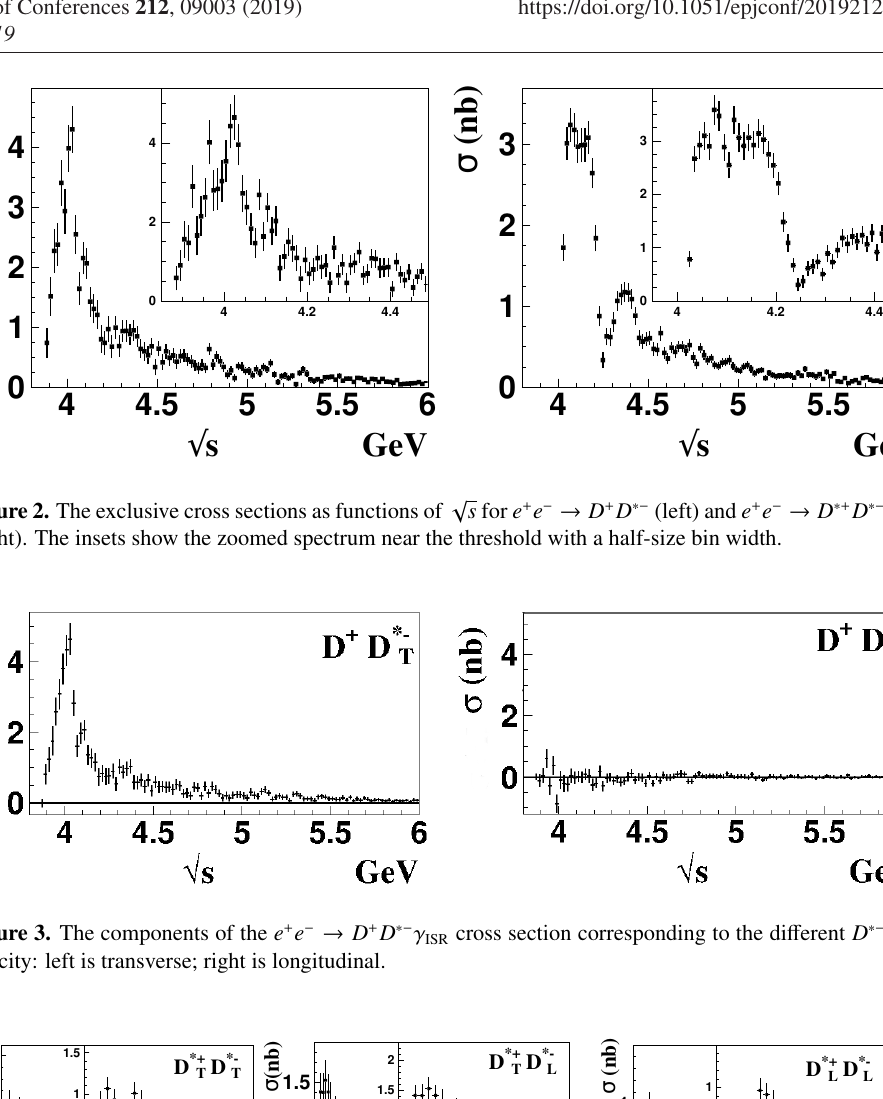
D + D ∗− γ ISR cross section corresponding to the di ff erent D ∗− →